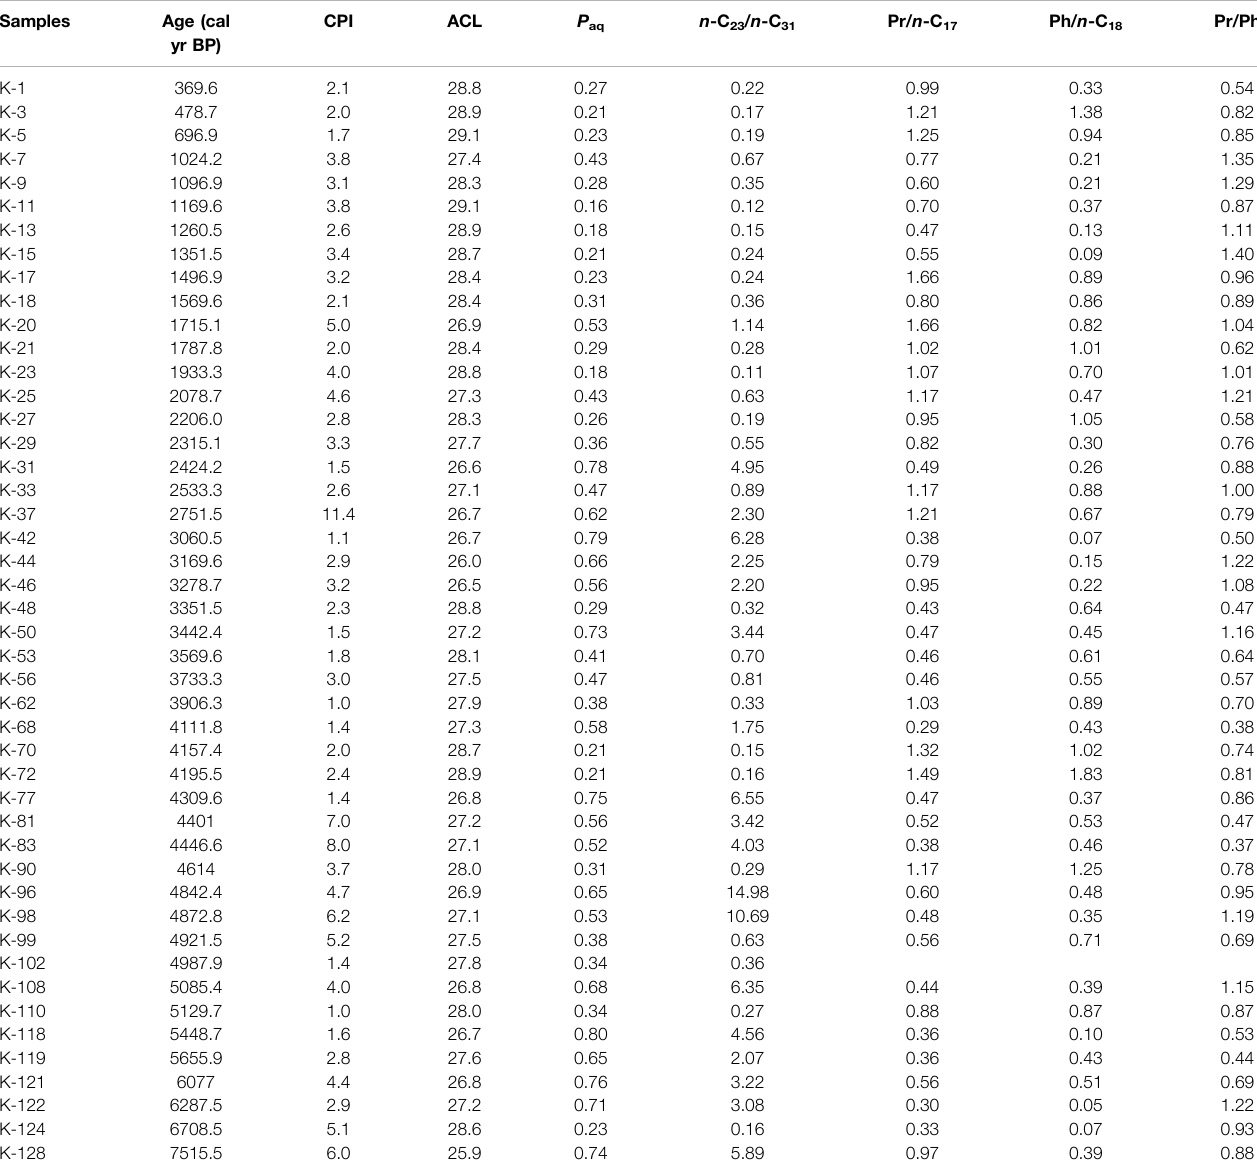
TABLE 1 | A list of n -alkane (CPI, ACL, P aq and n -C 23 / n -C 31 ) and acyclic terpenoid (Pr/ n -C 17 , Ph/ n -C 18 and Pr/Ph)proxies acrossthe studied sedimentary succession from the Kedarnath region, Garhwal Himalaya.